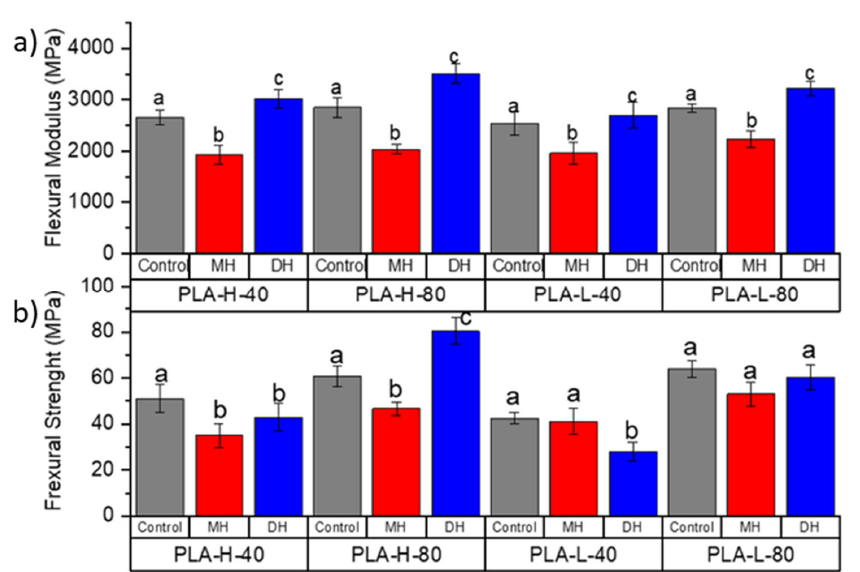
Figure 3. Change in the flexural modulus ( a ) and flexural strength ( b ) of the FDM dumbbells due to the DH or MH sterilization process as measured in the PLA 3D-printed samples. Grey bar: control sample; blue bar: dry heat sterilization; and red bar: moist heat sterilization. a–c Different letters show statistically significant differences between formulations ( p < 0.05).